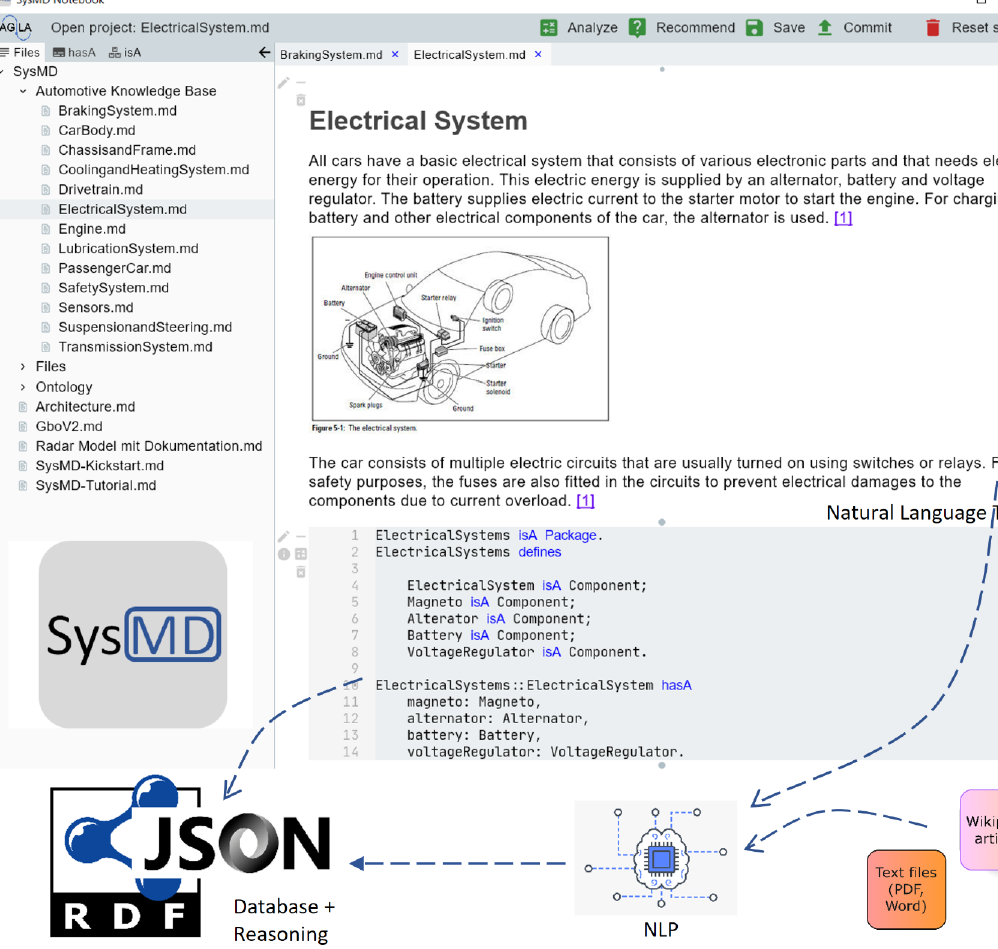
Figure 2. Electrical system and